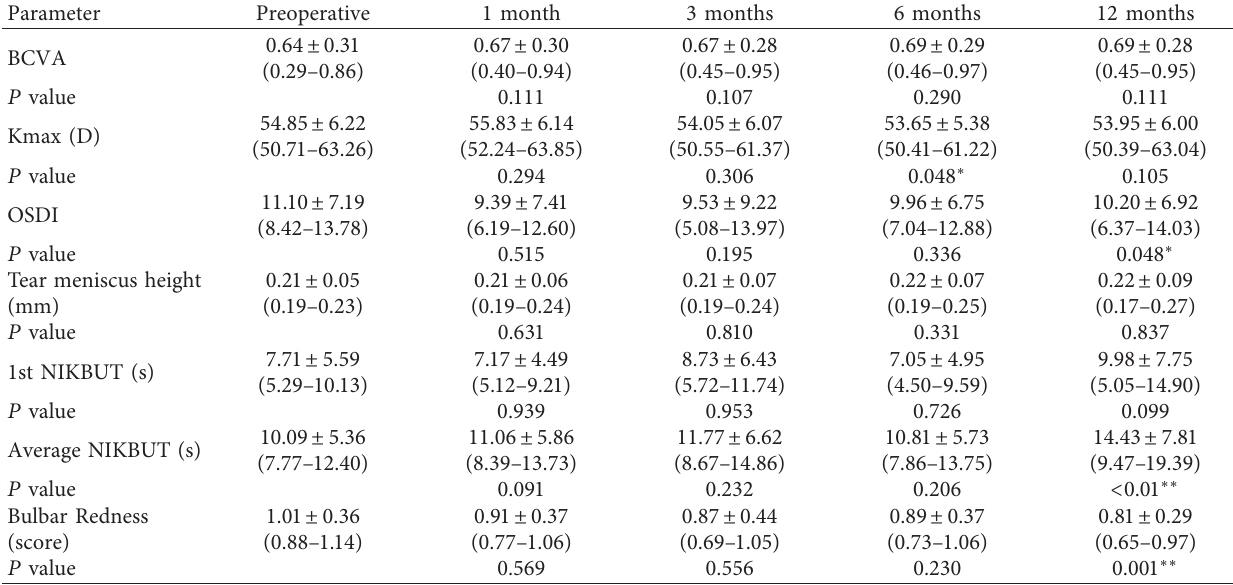
Table 2: Analysis of parameter changes in the epi-off group during the follow-up